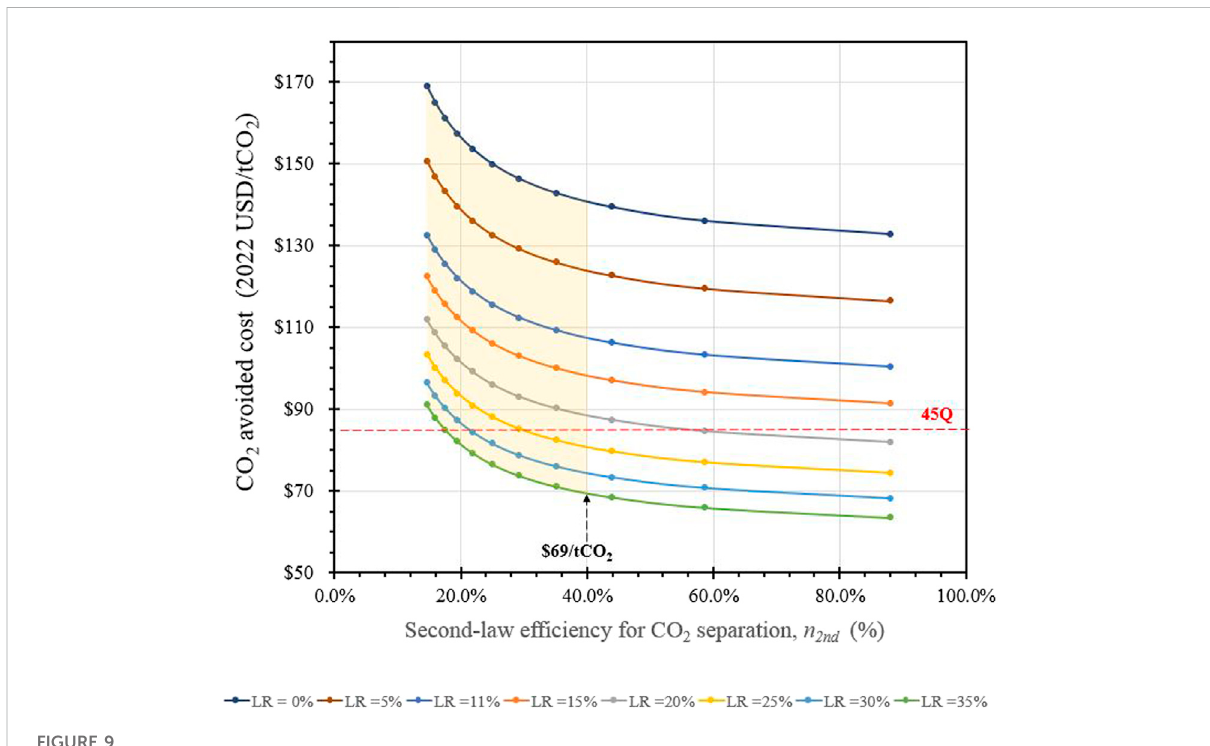
FIGURE 9 Effect of the variation of the learning rate of the PCC technology on the CAC. Note: The curves with learning rate values equal to 0% and 11% correspond to the cases NF_90% and NN_90%,